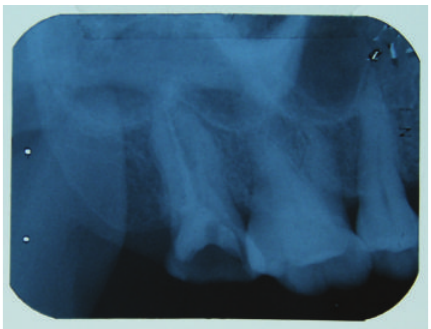
Figure 2: Dental radiograph showing the wide and deep caries lesion on tooth 17, with unfinished endodontic treatment. No periapical lesion was